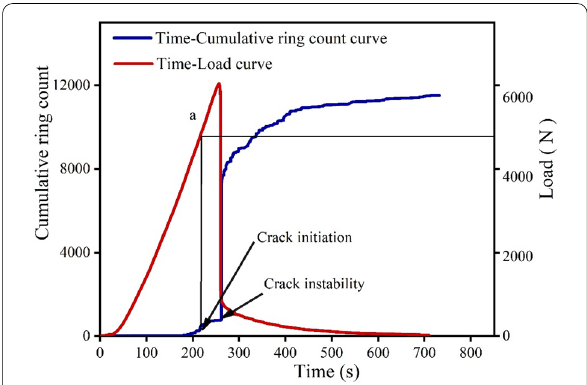
, P and CMOD ini c